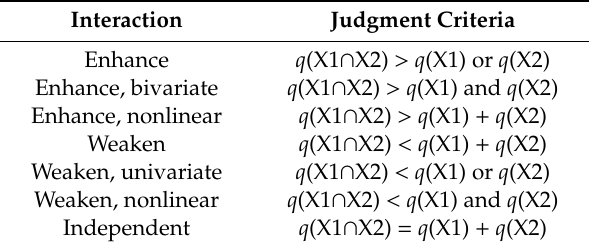
Table 1. Types of interaction between two